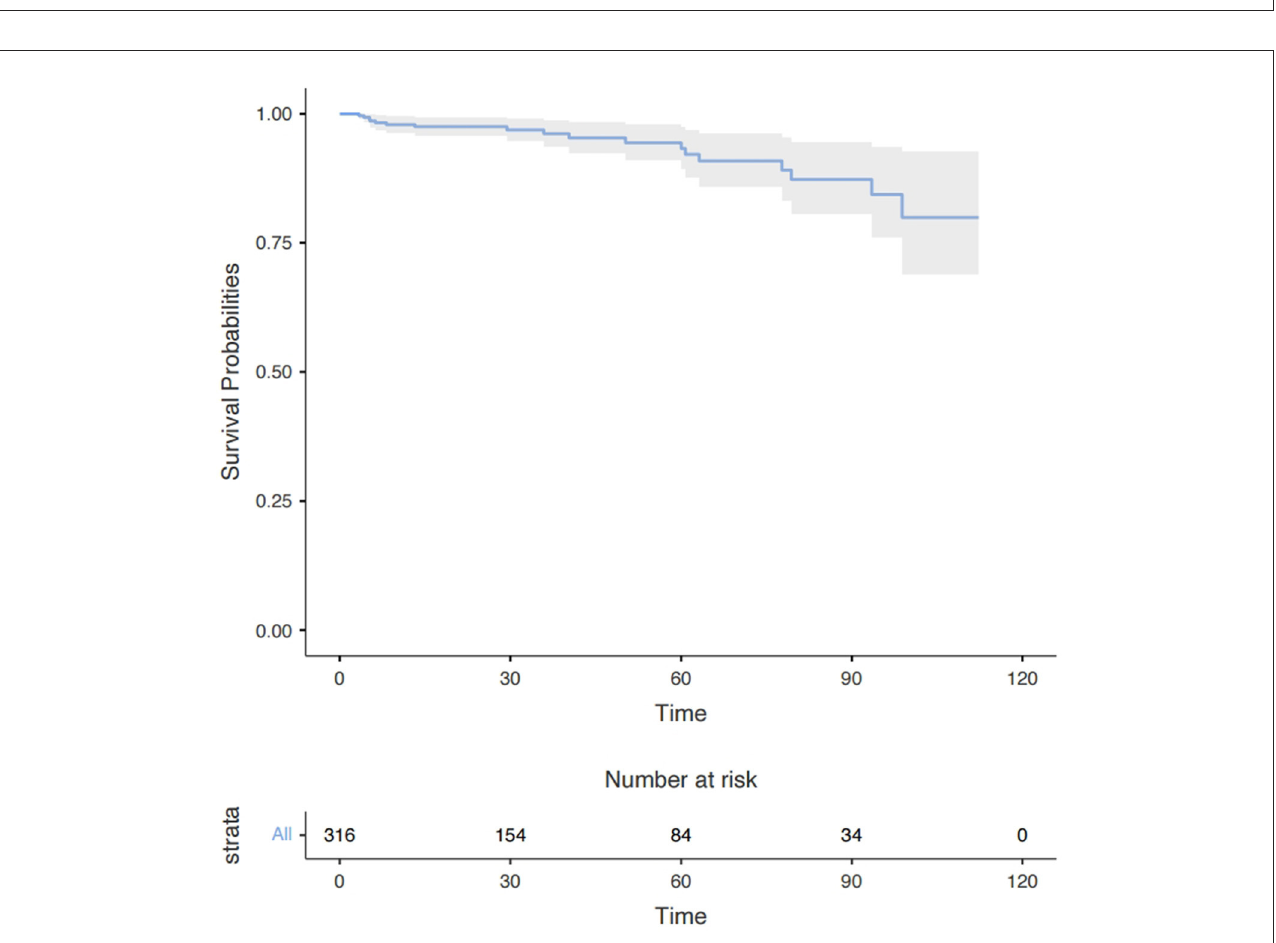
FIGURE3 Long-term survival in all patients with moderate AI and concomitant mild MR after the surgery. Data are presented as median with interquartile range. AI, aortic insufficiency; MR, mitral regurgitation.